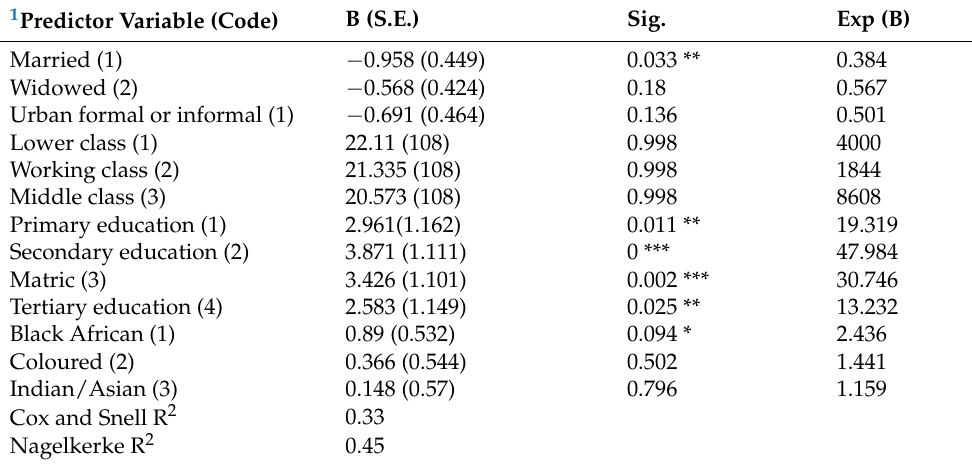
Table 2. A binomial regression analysis on Perceived poverty (Model